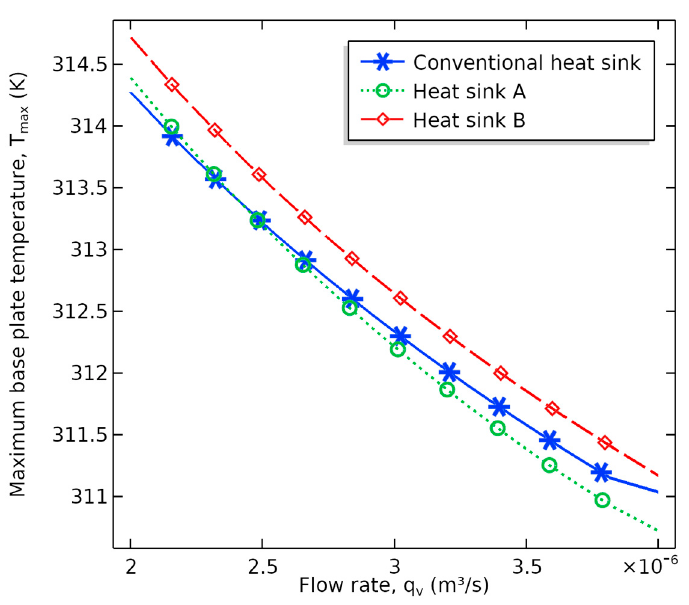
Figure 10. Maximum temperature at the base plate of the heat sink versus volumetric flow rate.